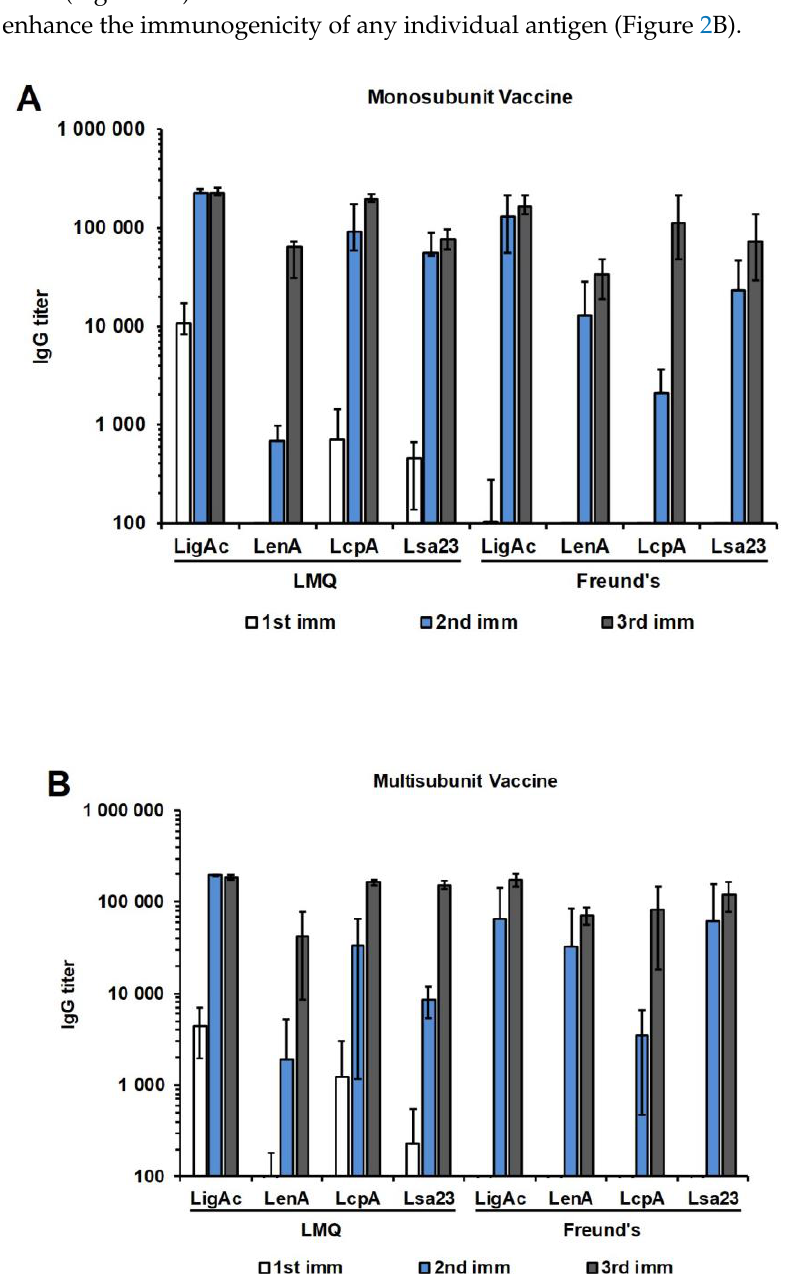
Figure 2. Antibody levels in mice immunized with various recombinant factor H binding protein (FHBP) subunit vaccine formulations. The vaccines were formulated with either LMQ (a combination of neutral liposome, monophosphoryl lipid A, and Quillaja saponaria fraction 21) or Freund’s adjuvants. The antibody titers at one week after each immunization (imm) were measured by enzyme-linked immunosorbent assay (ELISA). ( A ) Antibody titers after immunization with individual recombinant proteins as mono-FHBP (LigAc, LenA, LcpA, and Lsa23) subunit vaccines. ( B ) Antibody titers after immunization with pooled recombinant FHBPs as a multisubunit vaccine. The specific antibody titers to tested antigens shown (as bars) were determined by subtracting the titers for nonspecific reactivity to recombinant 6 × His tag non-FHBP (recombinant LipL32) and BSA from the total titers. The results are shown as mean ±